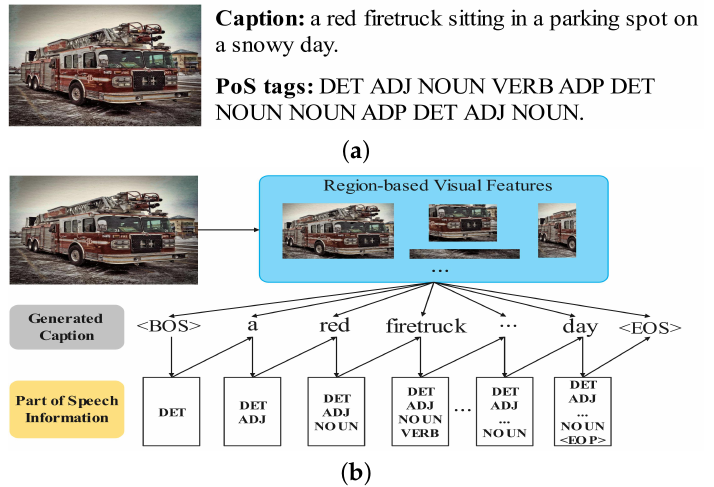
Figure 1. An example of PoS-guided caption generation. The PoS and word information are main- tained in separate streams. ( a ) The PoS tags and the corresponding words in an image description sentence. ( b ) Our model first predicts the most appropriate subsequent PoS by the previous words at each time step. Then, the obtained PoS information is used to guide the visual and linguistic attention for the word prediction. “ < BOS > ” and “ < EOS > ” denote the beginning and end of all the sentences, respectively. “ < EOP > ” is short for “ < End of PoS > ”, which is the end of all the PoS